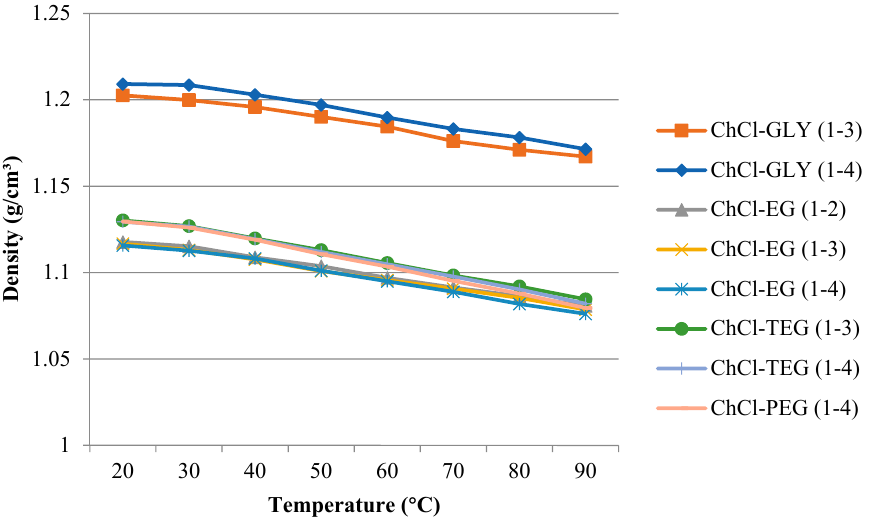
Figure 2. Density of DES with increasing temperature.